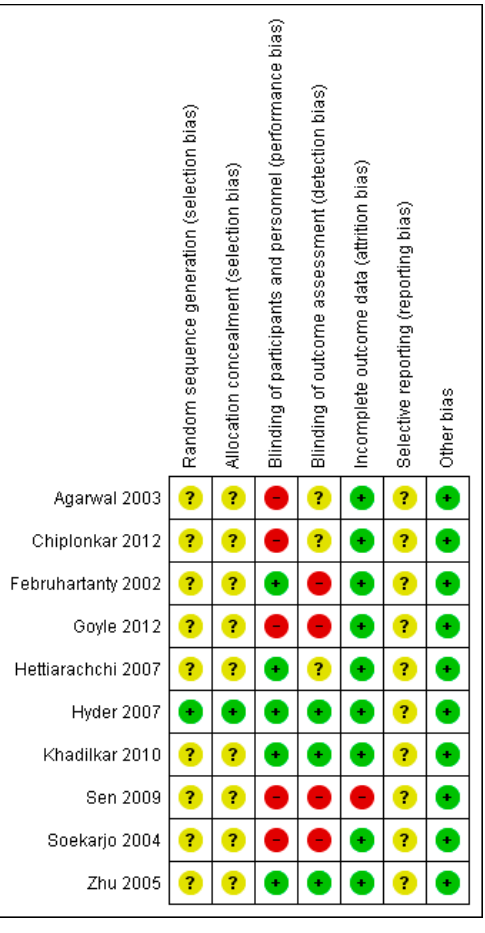
Figure 2. Risk of bias summary.